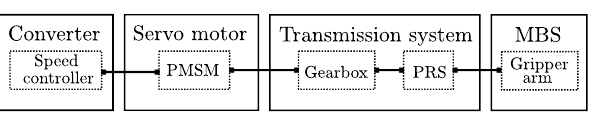
Figure 8: EMC drivetrain model connected to the me- chanical